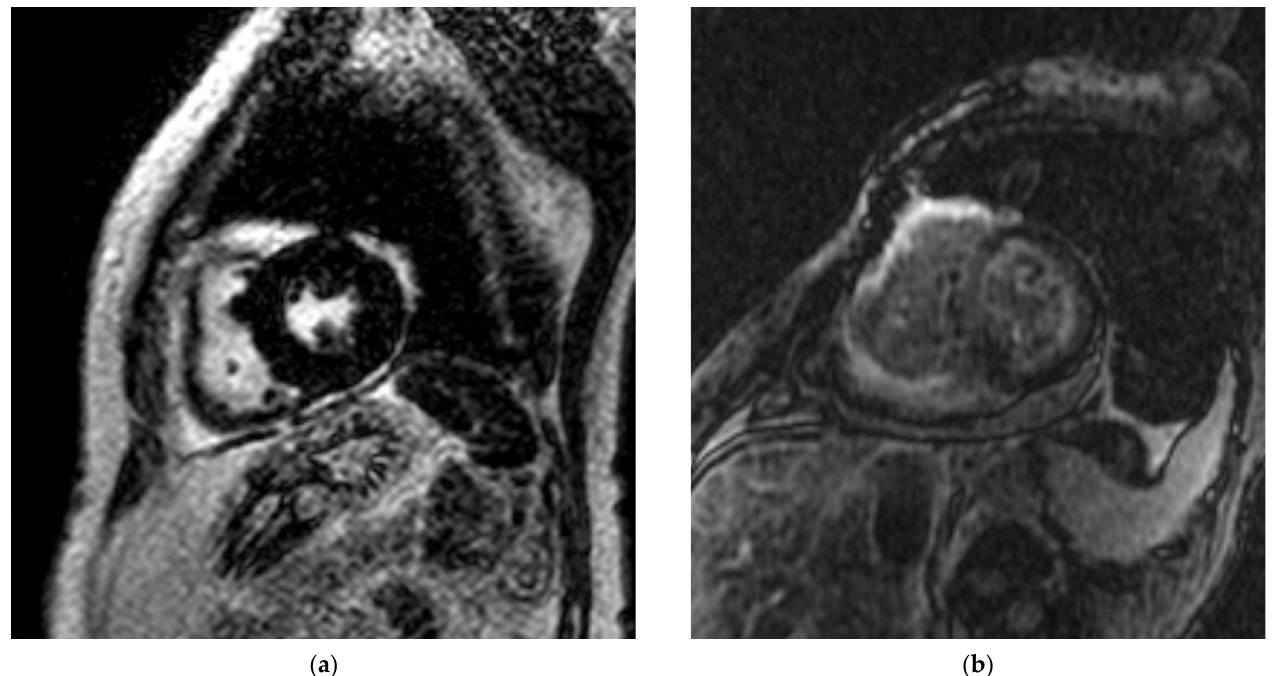
Figure 4. Representative case of RCM patient who died. ( a ) A 72-year-old female with multiple myeloma and hypertension referred for cardiac magnetic resonance to evaluate infiltrative cause of restrictive cardiomyopathy. Late gadolinium enhancement image does not show positive signal enhancement of the left ventricular myocardium. Patient’s left ventricular systolic function was 45% and LA reservoir strain was 14%. Patient expired six months after the CMR was performed. ( b ) A 62-year-old woman with multiple myeloma and hypertension referred for CMR to evaluate for un- derlying cause of restrictive cardiomyopathy. Late gadolinium enhancement image showed positive global subendocardial late gadolinium enhancement of the left and right ventricular myocardium. Patient’s left ventricular systolic function was 45% and left atrial function by LA reservoir strain was 14%. Patient expired two weeks after this CMR. CMR = cardiac magnetic resonance; LA = left